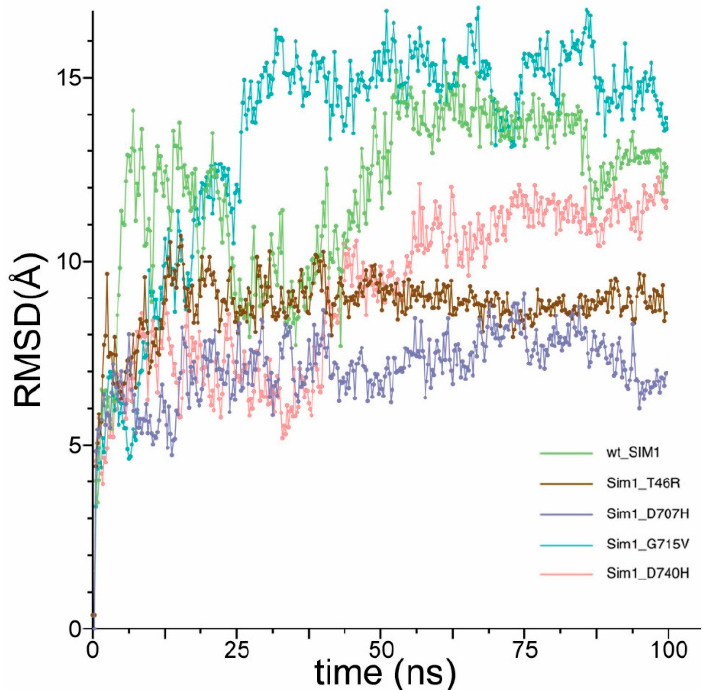
Figure 6. Global root-mean-square-deviation (RMSD), a metric for large-scale conformational changes of SIM1 variants versus WT. Global root-mean-square-deviation for each variant is given, where every residue from the protein is averaged into an accumulated measure of the total amount of change of the structure as a function of time. Colors are given in the figure